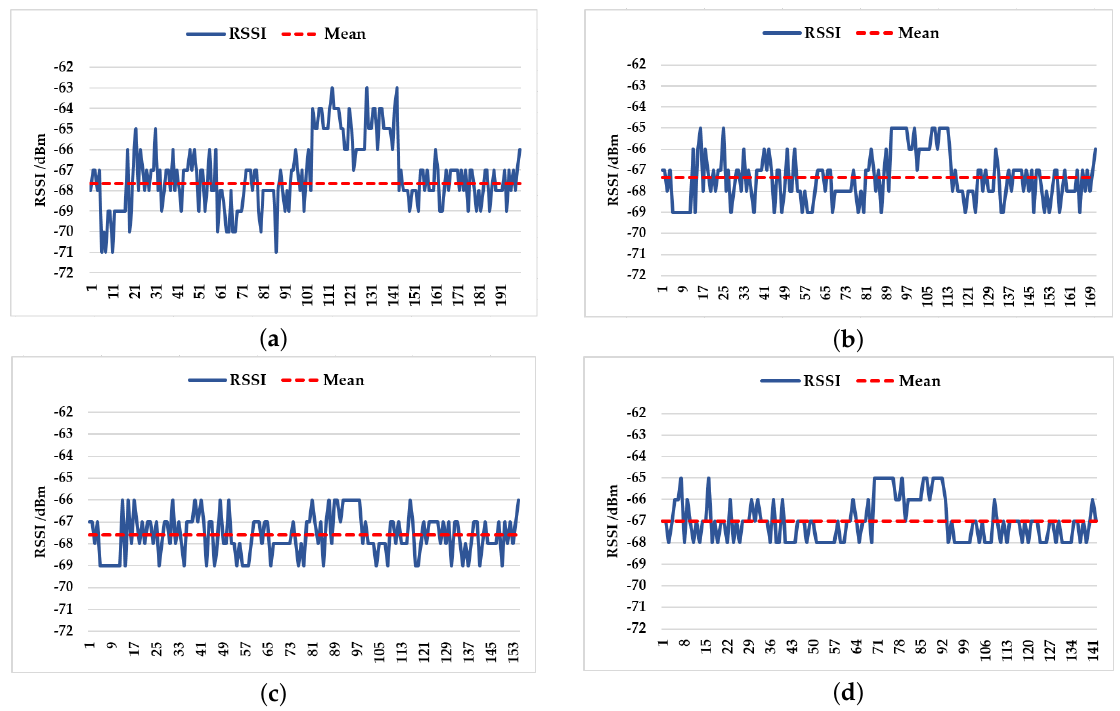
Figure 5. ( a ) The raw RSSI data and their mean values before Gaussian filtering. ( b ) The relationship between RSSI data within 90% of the probability and their mean. ( c ) The RSSI data within 80% of the probability and their data. ( d ) The relationship between the RSSI data within 68.3% of the probability and their